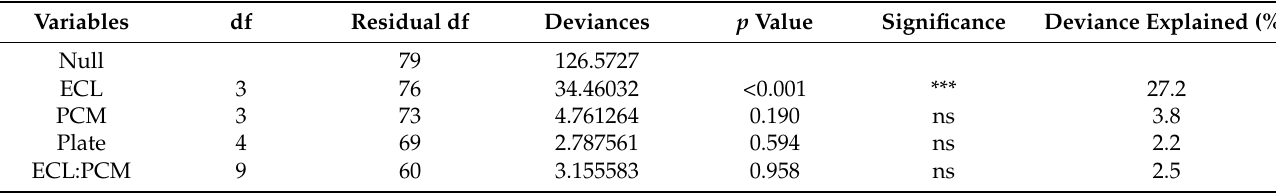
Table 12. Summary of deviances of the generalized linear model (GLM) of data from Table 11 (effect of proliferation culture media (PCM) on somatic embryo maturation efficiency of sugi embryogenic cell lines (ECLs)). Deviance of the variable “null” indicates the null deviance (deviance of the null model), and other deviances indicate the residual deviance (deviance of the variable). Variables